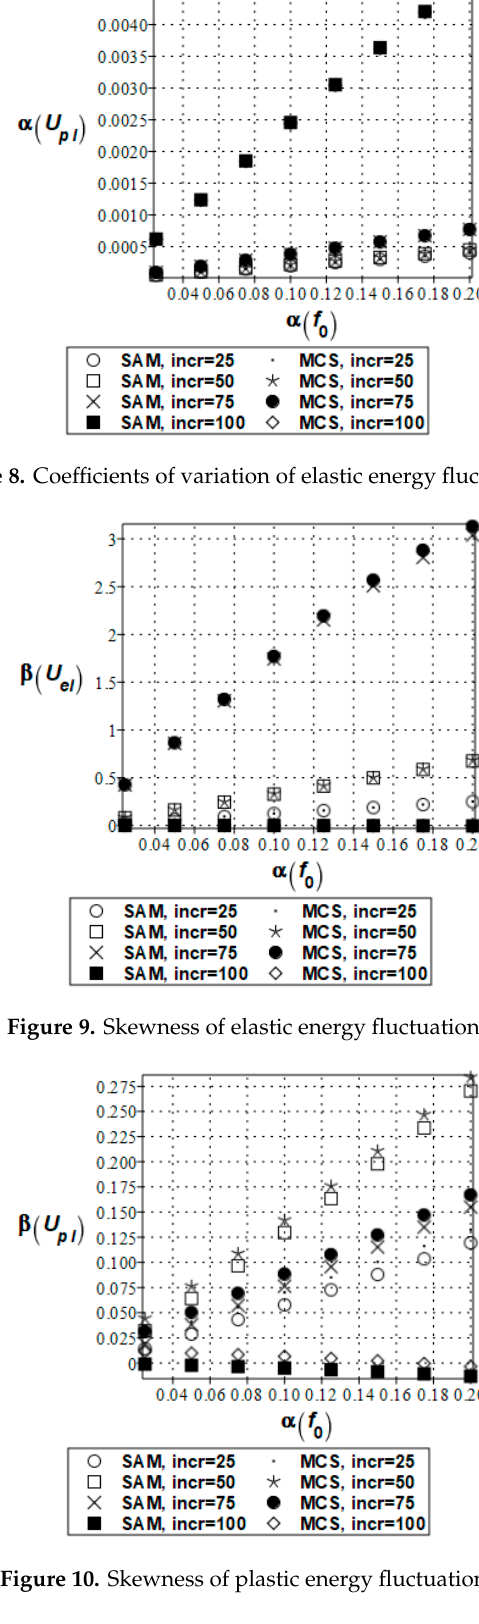
Figure 11. Kurtosis of elastic energy fluctuations.